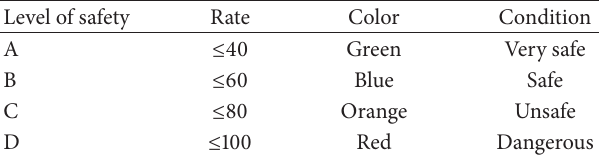
Table 15: Definition of level of provincial highway safety.